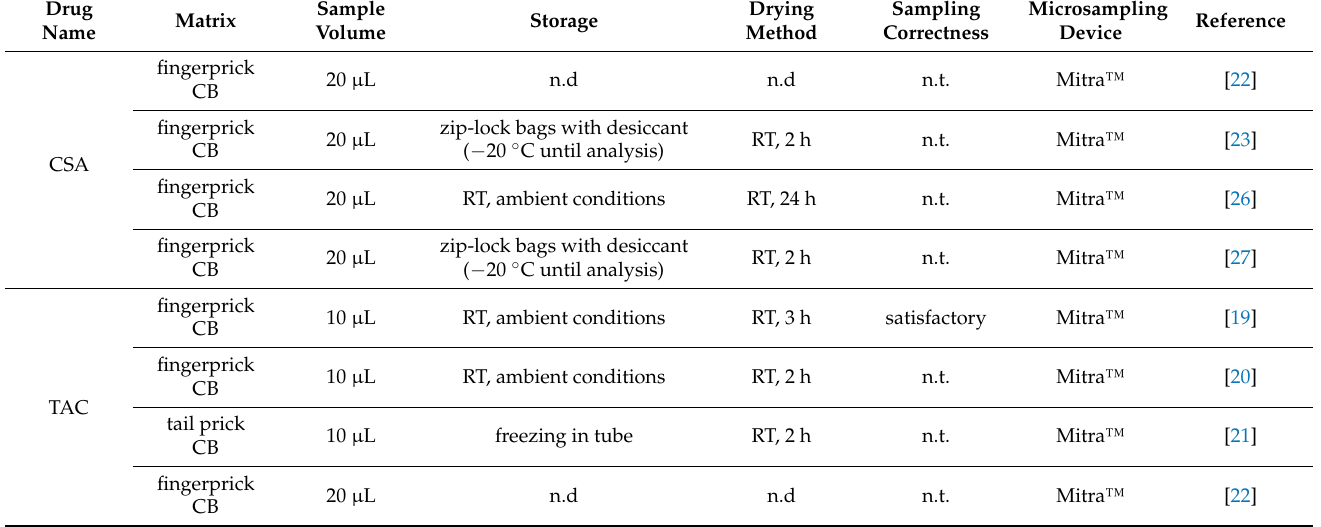
Table 1. Summary of the preanalytical characteristics of immunosuppressive drug assays using VAMS microsampling